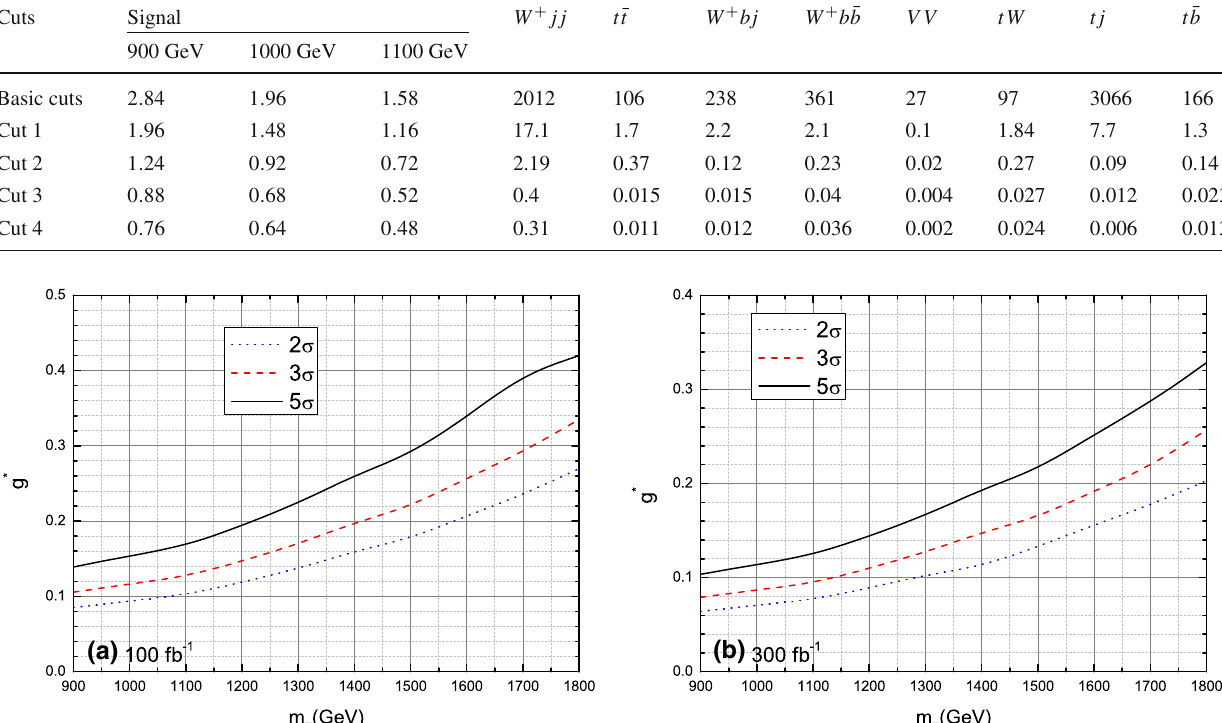
Fig. 7 The 2 σ , 3 σ and 5 σ contour plots for the signal in g ∗ − m T at 14 TeV LHC with two typical values of integrated luminosity: a 100 fb − 1 , b 300 fb −